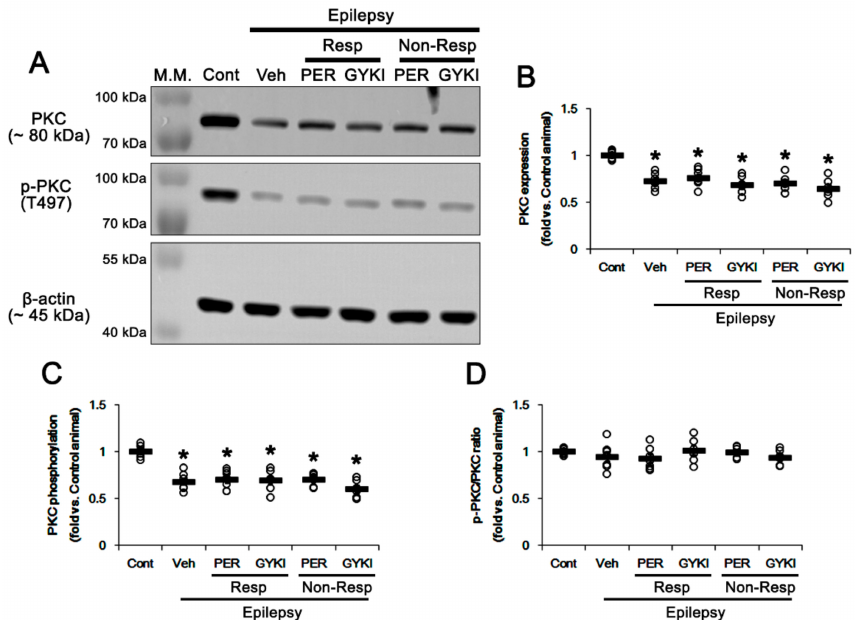
Figure 4. The effects of perampanel (PER) and GYKI 52466 (GYKI) on total protein kinase C (PKC) expression and its threonine (T) 497 phosphorylation in chronic epilepsy rats. ( A ) Representative images for western blot of PKC and its T497 phosphorylation level in the hippocampal tissues. ( B – D ) Quantifications of PKC ( B ), p-PKC T497 ( C ), and p-PKC/PKC ratio ( D ) in the hippocampal tissues. Open circles indicate each individual value. Horizontal bars indicate mean value. Error bars indicate SEM ( * p < 0.05 vs. control animals; one-way ANOVA with post hoc Bonferroni’s multiple